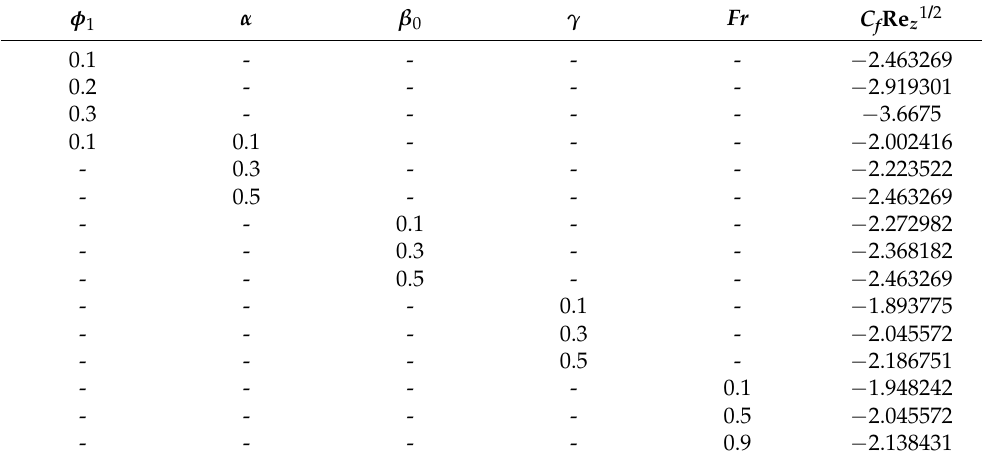
Figure 6. Bejan number variation for distinct values of ( a ) is β 0 , ( b ) is φ 1 , ( c ) is γ , ( d ) is Br . Table 2 indicates how the numerous constraints affect the skin friction. It is determined that skin friction coefficient decreases for large values of the volume fraction, fluid parameter, porosity parameter, curvature parameter, and inertia coefficient. Table 3 indicates the numeric data of the Nusselt number for a variety of constraints. It is determined that Nusselt number decreases for large values of the volume fraction, fluid parameter, porosity parameter, and temperature ratio, whereas it upsurges for superior values of the curvature parameter. Table 4 compares the numeric values of skin fraction with the pervious result. Both outcomes are noticed to be highly congruent. Table 2. The skin friction coefficient variation for numerous values of φ 1 , α , β 0 , γ , and Fr .